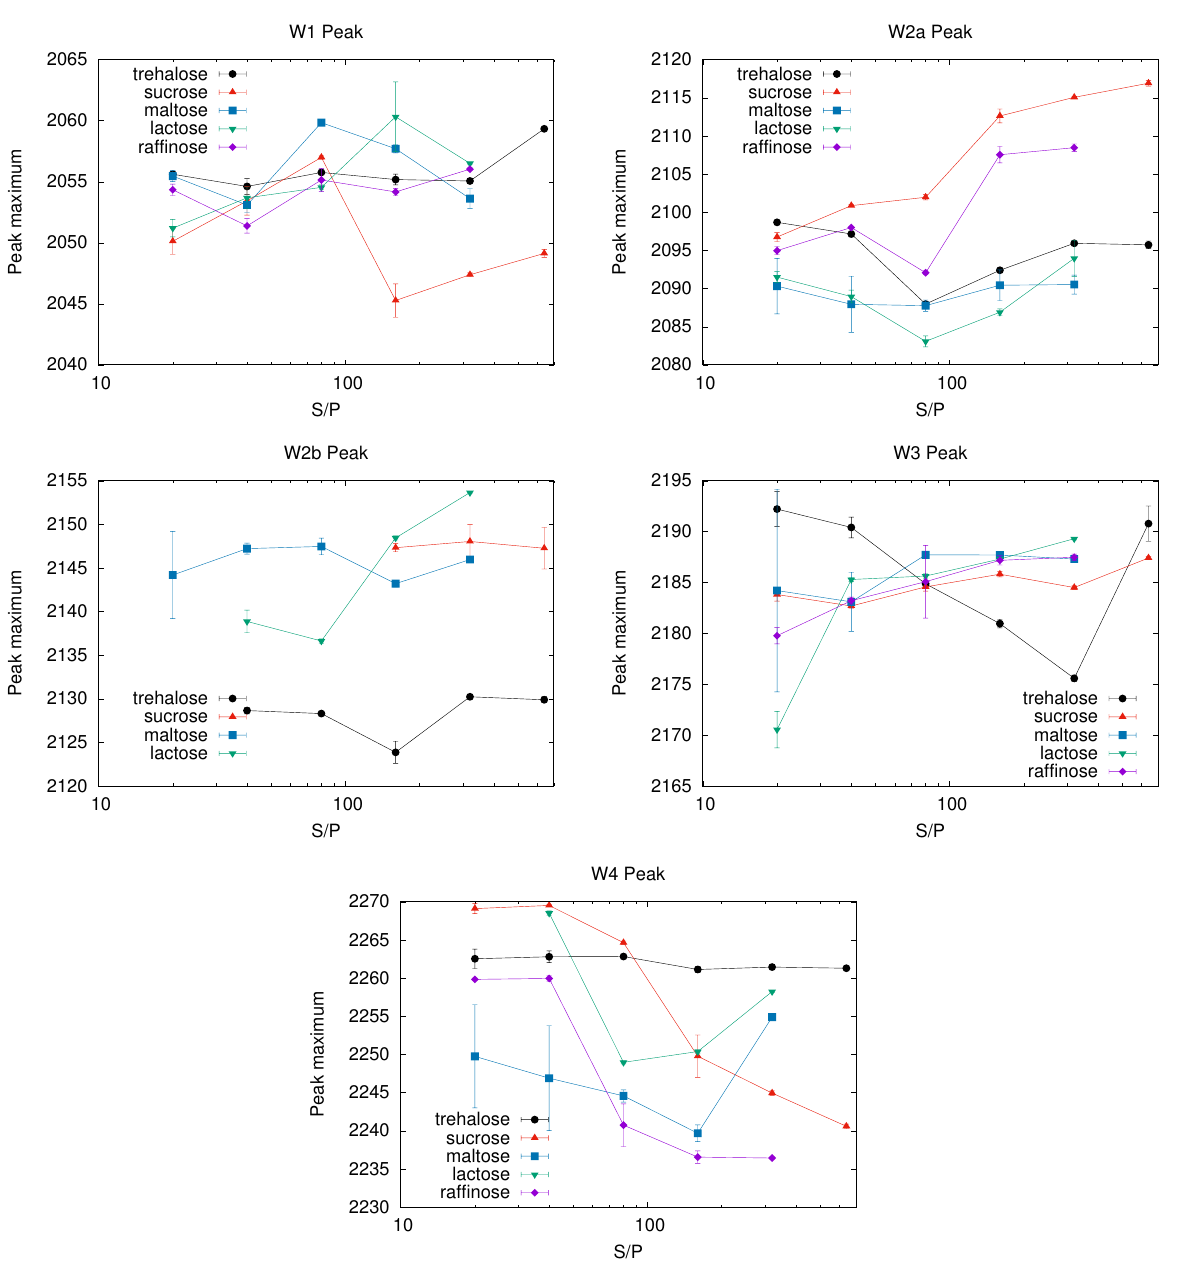
Figure 7. Peak frequencies of various sub-bands. As in the previous figures, the vertical bars are standard deviation on the population. The instrumental resolution uncertainty, estimated around 0.3 cm − 1 , is not included in the evaluation of the bars for sake of clarity. In almost all cases, within the errors, the populations interconvert with the sugar:protein ratio with no peak shift; the remarkable blue and red shifts occurring for W2a and W4 in sucrose, and for W3 in trehalose, could be attributed to the peculiarity of trehalose and sucrose in modulating the strength of the protein-water-sugar interactions established in the